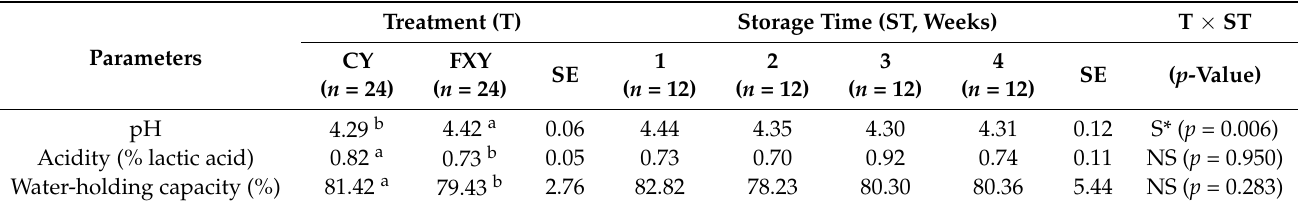
Table 5. Effect of fucoxanthin supplementation on pH, titratable acidity, and water-holding capacity of goat whole milk yogurt during